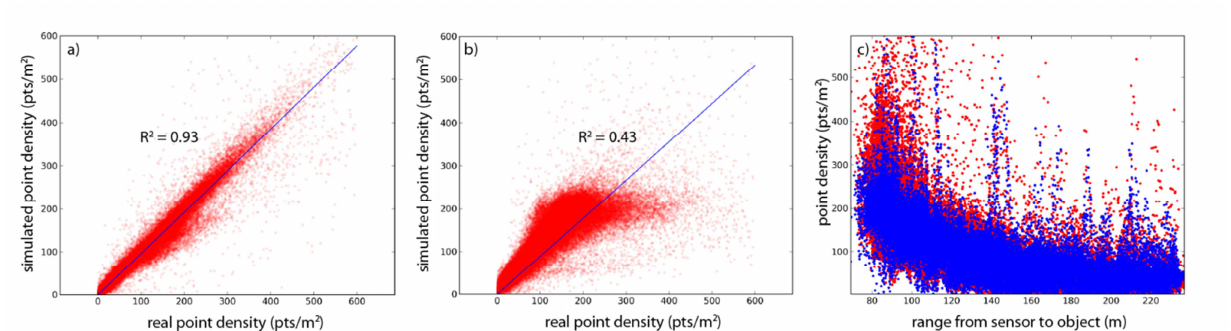
Figure 10. Comparison of real and simulated point densities: a) scatterplot of the relationship between real point densities and simulated point densities (flown trajectories); b) scatterplot of the relationship between real point densities and simulated point densities (planned trajectories); c) scatterplot of the relationship between scan range and point density for simulated data (planned trajectory = blue and real data =